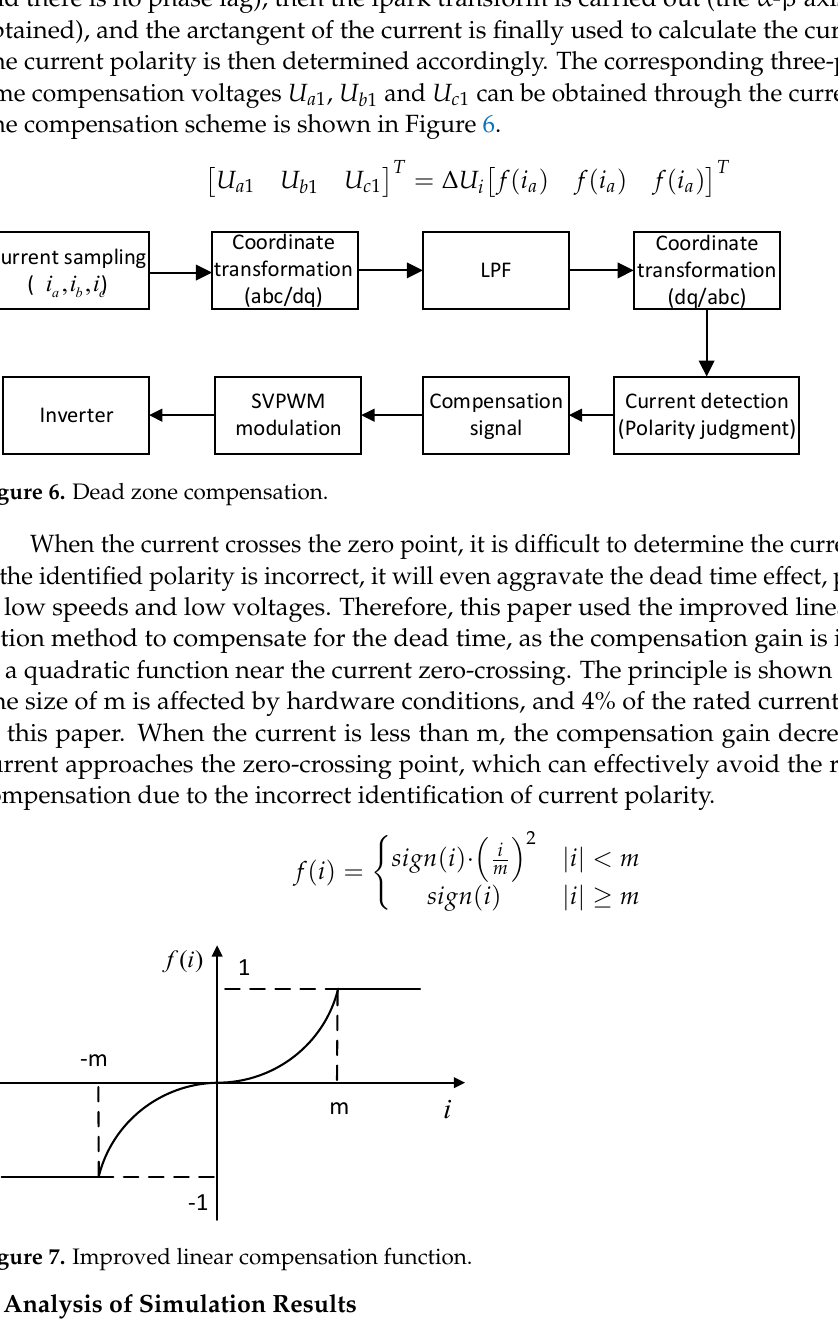
Figure 7. Improved linear compensation function.